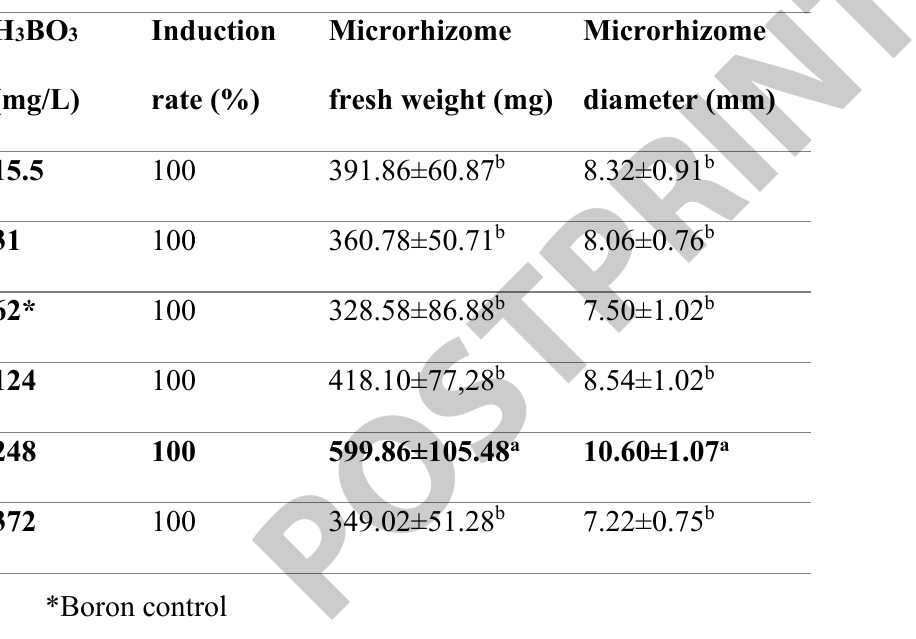
Table 6. Impact of different H 3 BO 3 (Boron) concentrations on microrhizome induction and